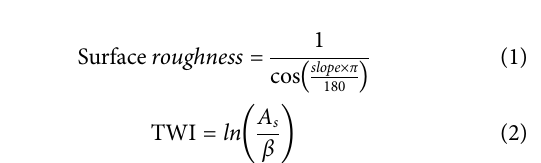
Frontiers in Earth Science |